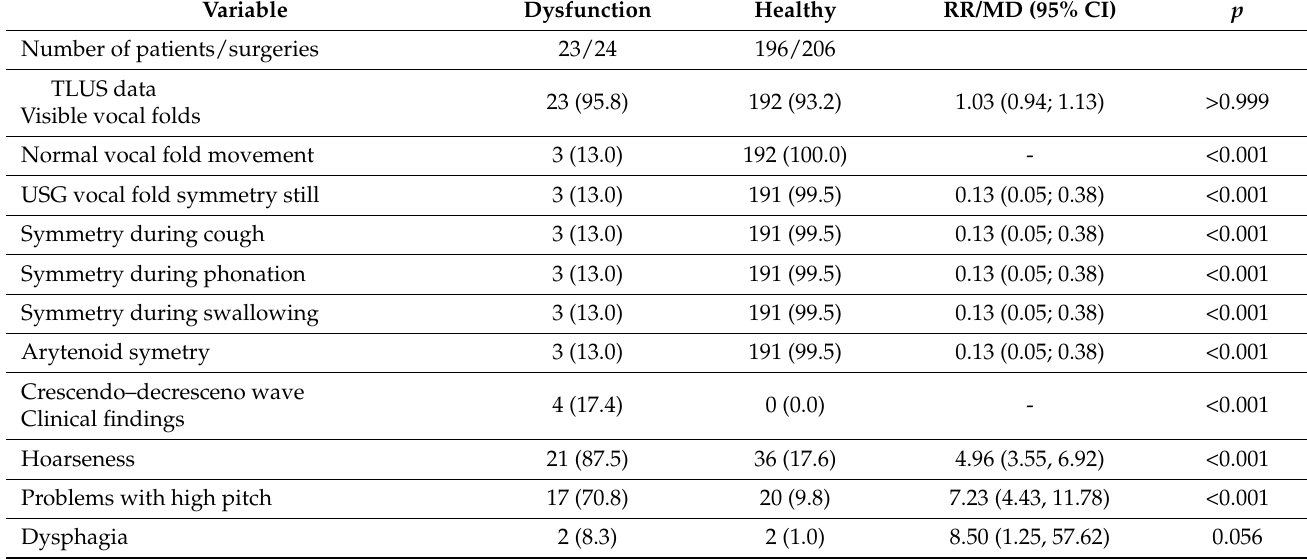
Table 7. Comparison of dysfunction and healthy cases 1–3 days after